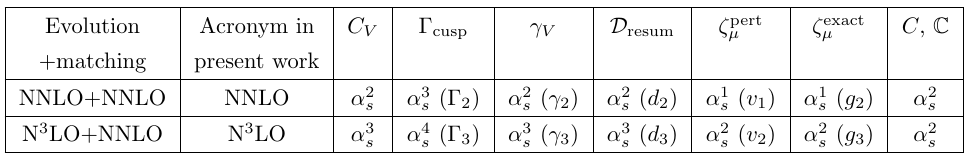
Table 1 . Summary of the perturbative orders used for each part of the factorized cross sec- tion. The evolution of (cid:11) s is provided by the LHAPDF library and comes together with PDF set (uniformly nnlo). In brackets we write the last included term of corresponding perturbative expansion (B.4), (B.5), (C.4), (C.8),